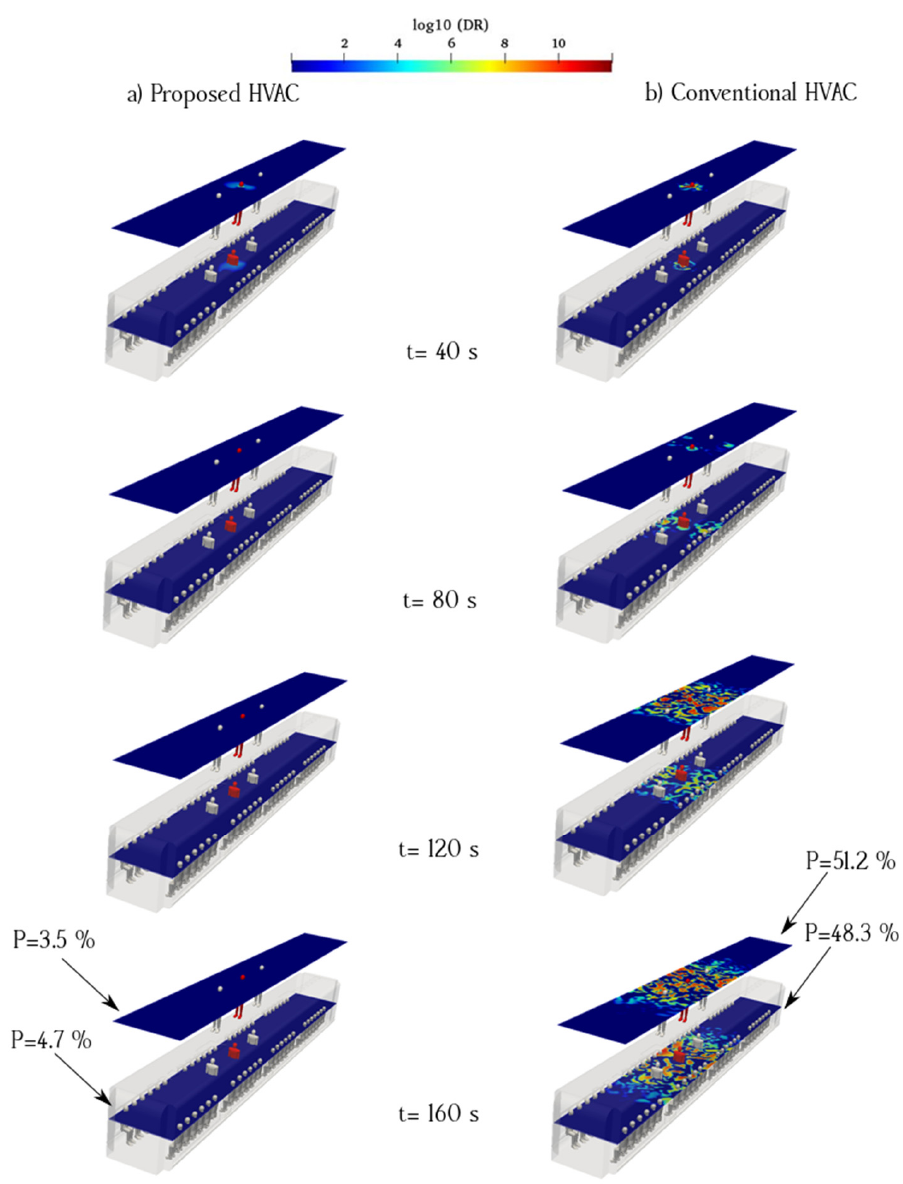
Figure 11. Time evolution of the counters of log 10 (DR) when the infected individual is standing near the supply air ducts of the proposed ( a ) and conventional ( b ) HVAC systems (Case 3).